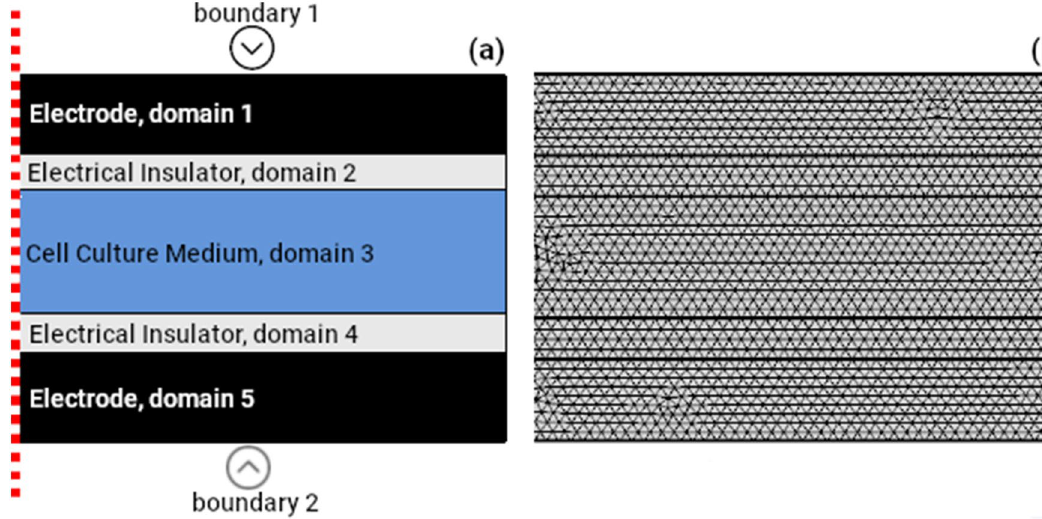
Figure 3. Axisymmetric representation of a typical CCoupled electric stimulation setup. ( a ) Domain identification of each layer, and electrical boundary conditions applied at the electrodes for FE analysis; ( b ) Example of a physics-controlled mesh obtained in COMSOL using the extra fine